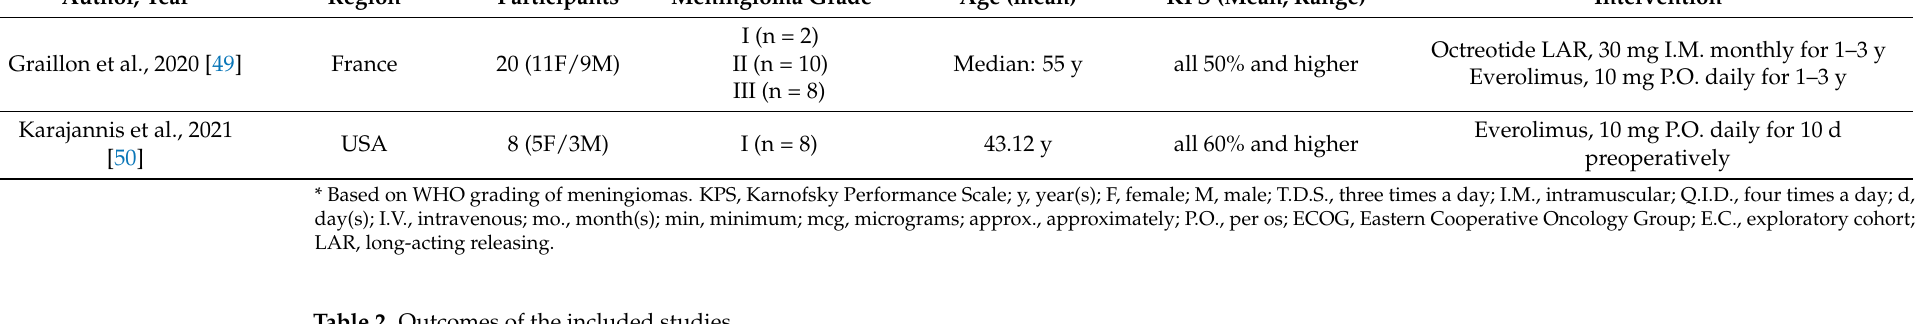
Table 2. Outcomes of the included